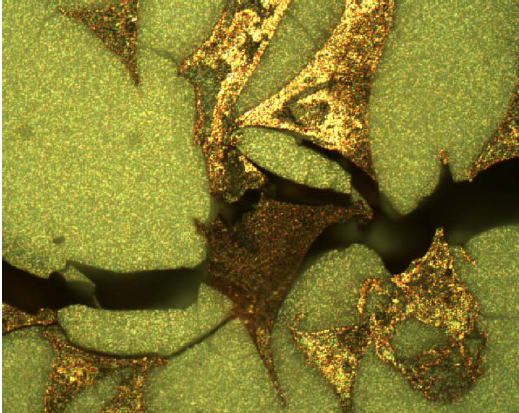
Figure 2: Detail of a fracture experiment on a Cu/Al 2 O 3 composite (courtesy of TUD)